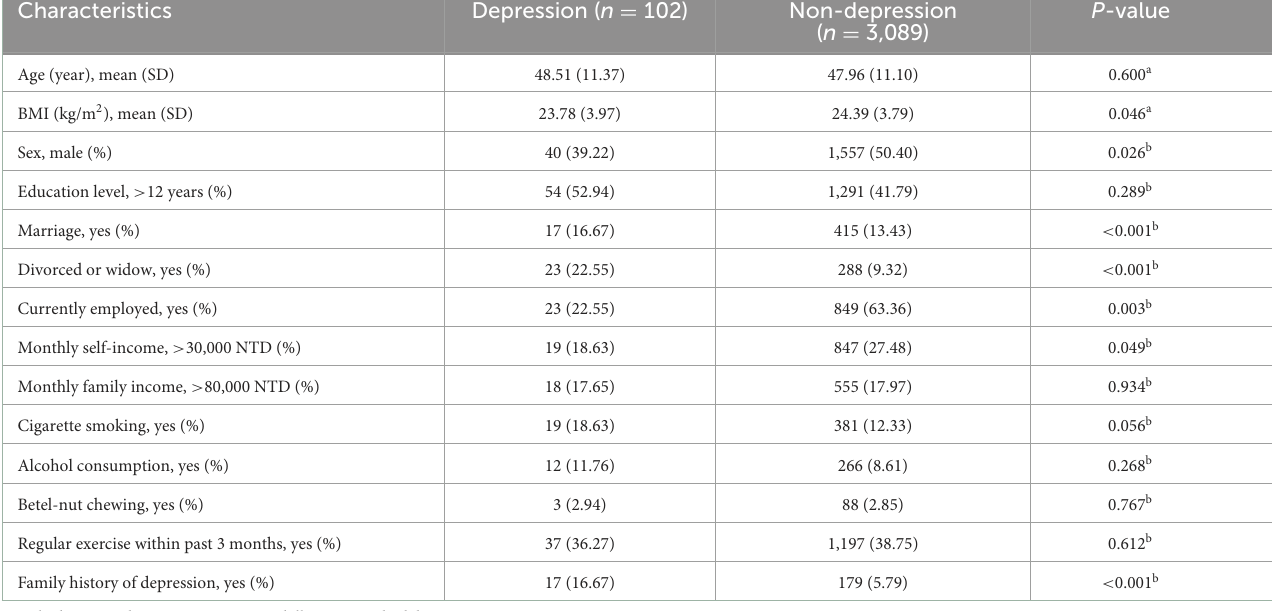
TABLE 1 Demographic characteristics of study participants in Taiwan Biobank from 2010 to 2019.